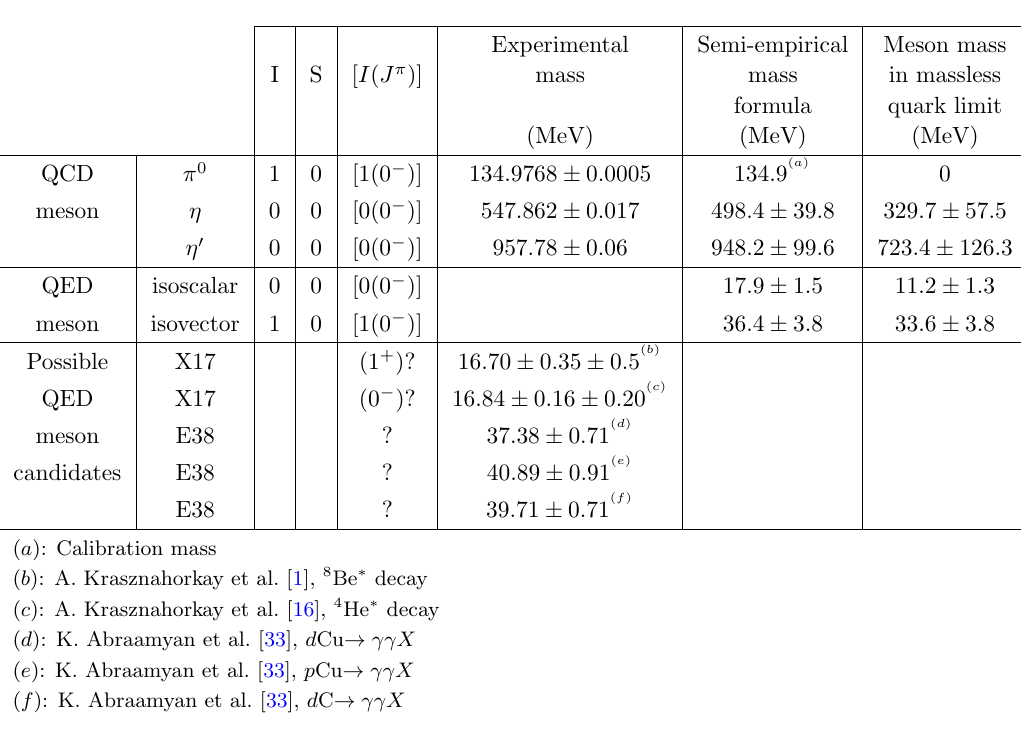
Table 1 . Comparison of experimental and theoretical masses of neutral, I 3 = 0, and S = 0 QCD and QED mesons obtained with the semi-empirical mass formula (2.37) for QCD mesons and (2.43) for QED mesons, with (cid:11) = 1 = 137, (cid:11) s = 0 : 68 0 : 08, and R T = 0 : 40 0 : 04 fm. QED (cid:6) (cid:6) of 0 : 6 used for the lowest meson masses in earlier hadron spectroscopy studies [93{96] as a measure of the degree of uncertainties in (cid:11) s , resulting in (cid:11) s = 0 : 68 0 : 08. (cid:6) For the value of R T , lattice gauge calculations with dynamical fermions give a (cid:13)ux tube root-mean-square-radius R T = 0 : 411 fm for a quark-antiquark separation of 0.95 fm [75]. p 2 The experimental value of of produced hadrons ranges from 0.2 to 0.3 GeV 2 for e + - T i h e (cid:0) annihilations at p s from 29 GeV to 90 GeV [83], corresponding to a (cid:13)ux tube